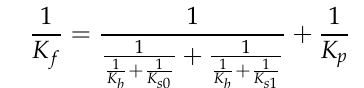
Figure 27. Configuration of the z -axis feed system and the dynamic model. ( a ) Configuration of the z -axis feed system. ( b ) The dynamic model.